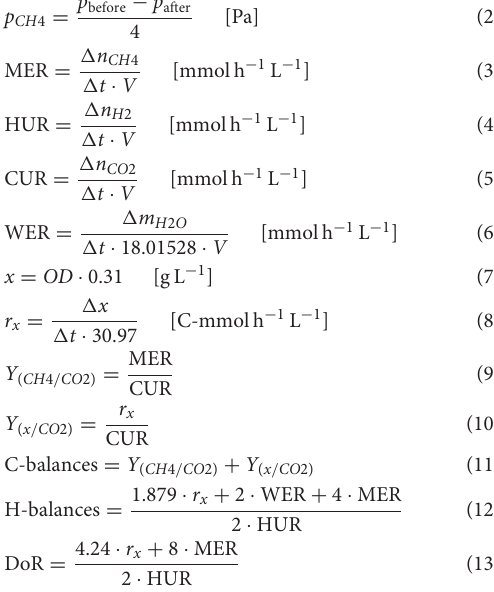
respective conversion factor. The last step was to measure